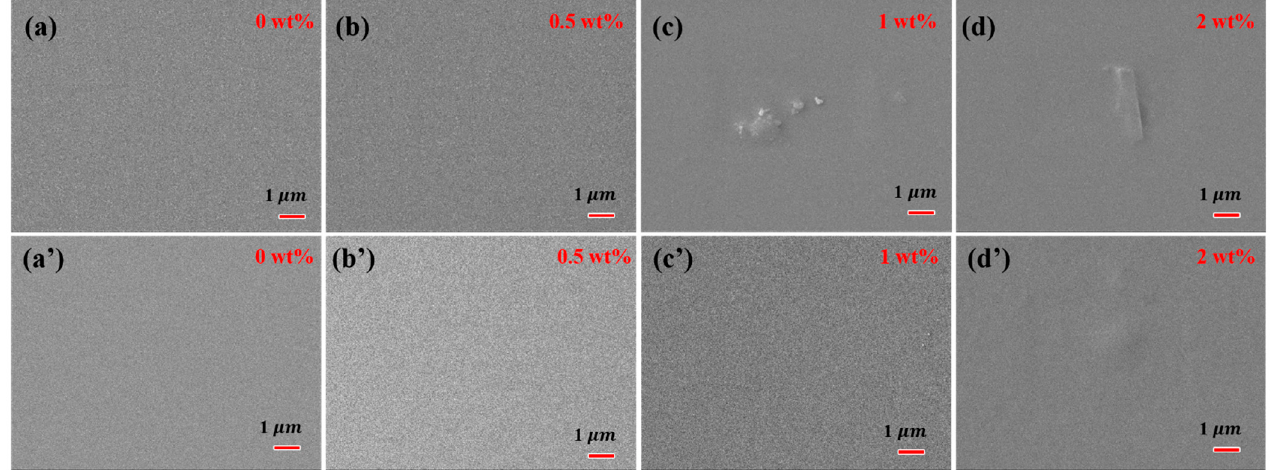
Figure 5. Surface morphology of GR/PVA MMMs ( up ) and GO/PVA MMMs ( down ). ( a , a' ) pure PVA membrane; ( b , b' ) filler loading of 0.5 wt%; ( c , c' ) filler loading of 1 wt%; ( d , d' ) filler loading of 2 wt%.